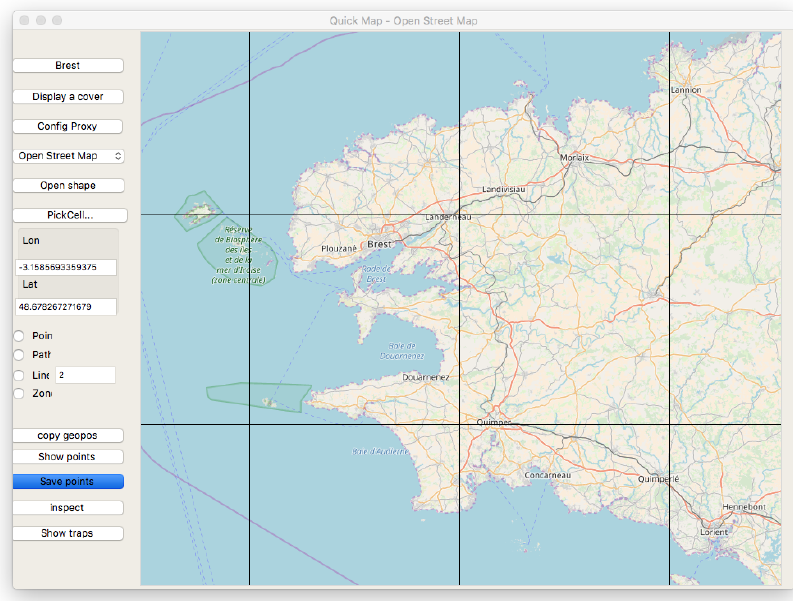
Figure 8. Quickmap tool [33] showing tile coverage. For this case, zoom factor is 9, and the last tile at the bottom right has x = 251, y = 177 indexes.